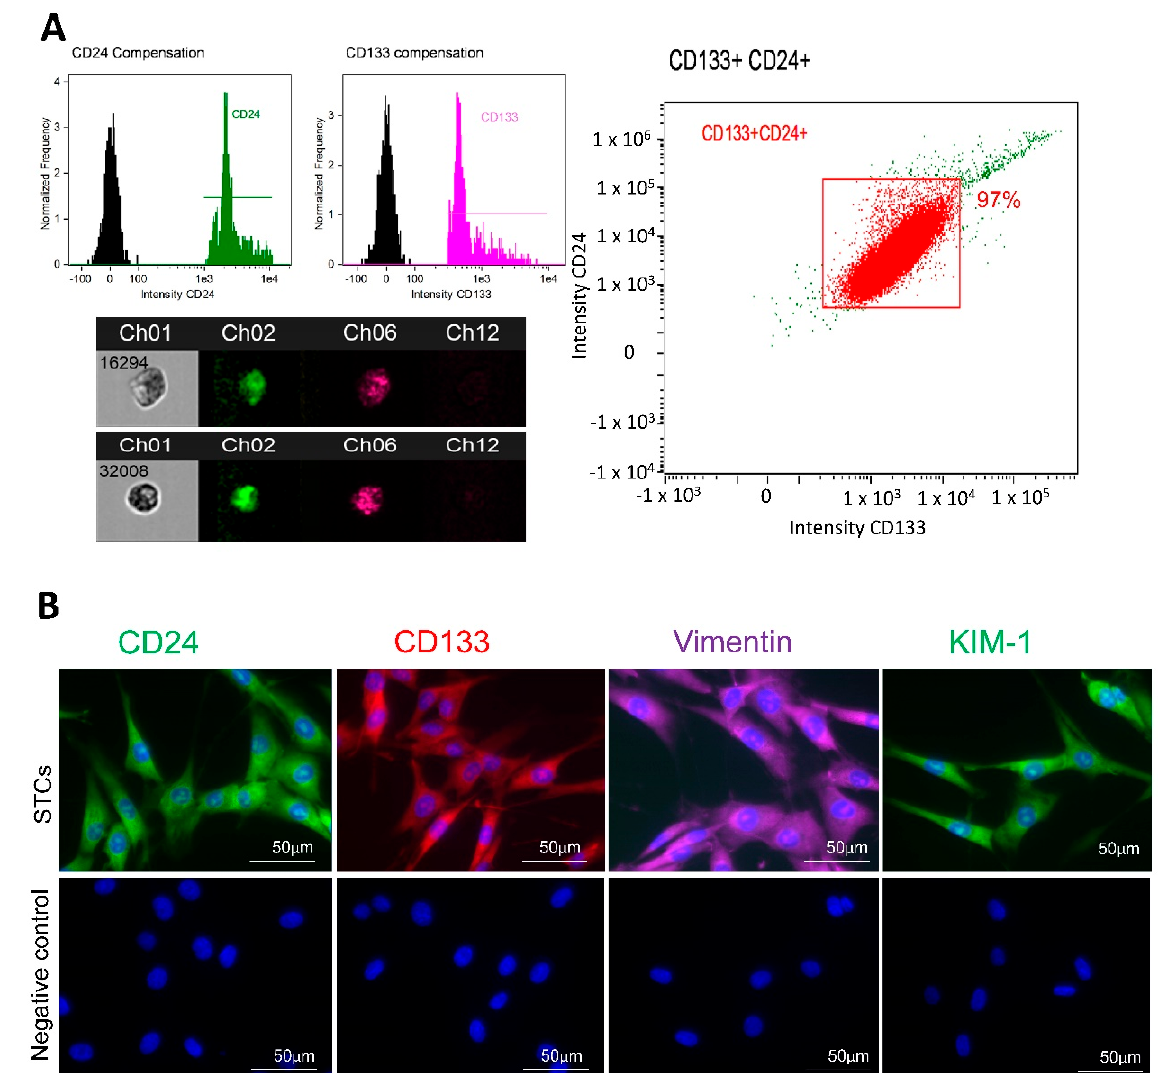
Figure 1. Characterization of scattered tubular-like cells (STCs) isolated from pig kidneys. ( A ): Flow cytometry analysis of isolated STCs co-expressing CD133 and CD24 (97%) and representative images of CD133+ (pink)/CD24+ (green) cells. ( B ): Immunofluorescence staining (original magnification: ×40) of swine STCs with antibodies against the surface markers CD24 (green), CD133 (red), vimentin (pink), and kidney injury molecule (KIM)-1 (green). Cells processed without primary antibodies served as negative controls.